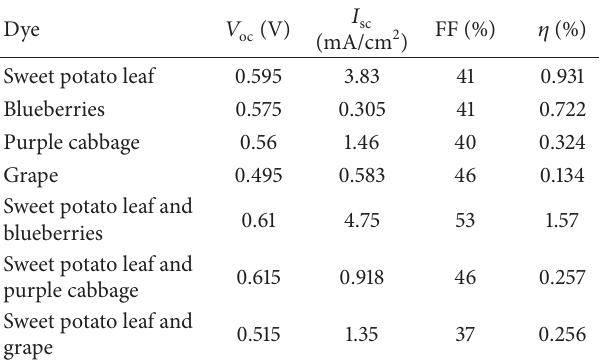
Table 3: The performance of DSSCs using natural dyes at a weight concentration of 40%.